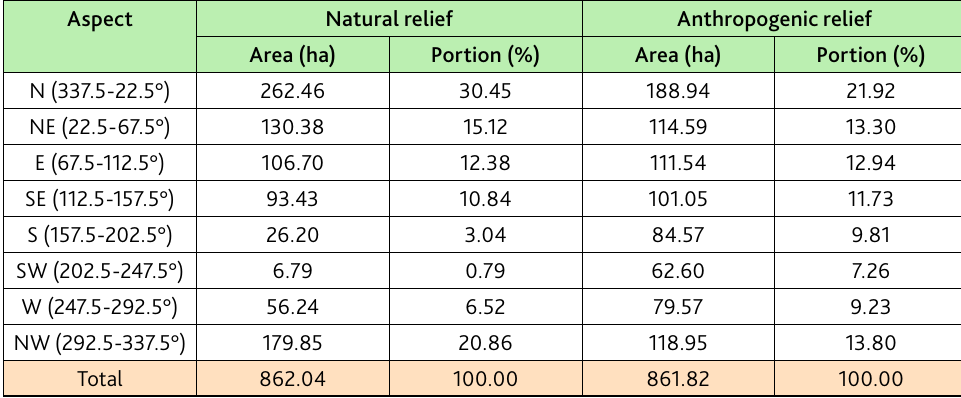
Table 3. Aspect categories and their spatial coverage Aspect Natural relief